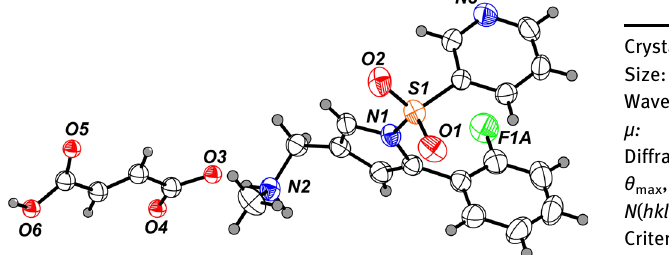
Table  : Data collection and